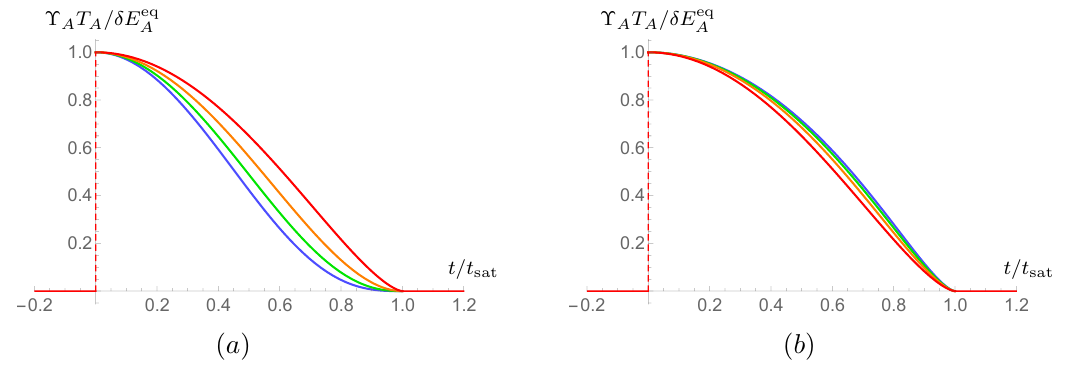
Figure 2 . Evolution of (cid:7) A ( t ), de(cid:12)ned in (2.42), for the case of the ball ( a ) and the strip ( b ) in d = 2 ; 3 ; 4 ; 5 dimensions, depicted in red, orange, green and blue, respectively. f g